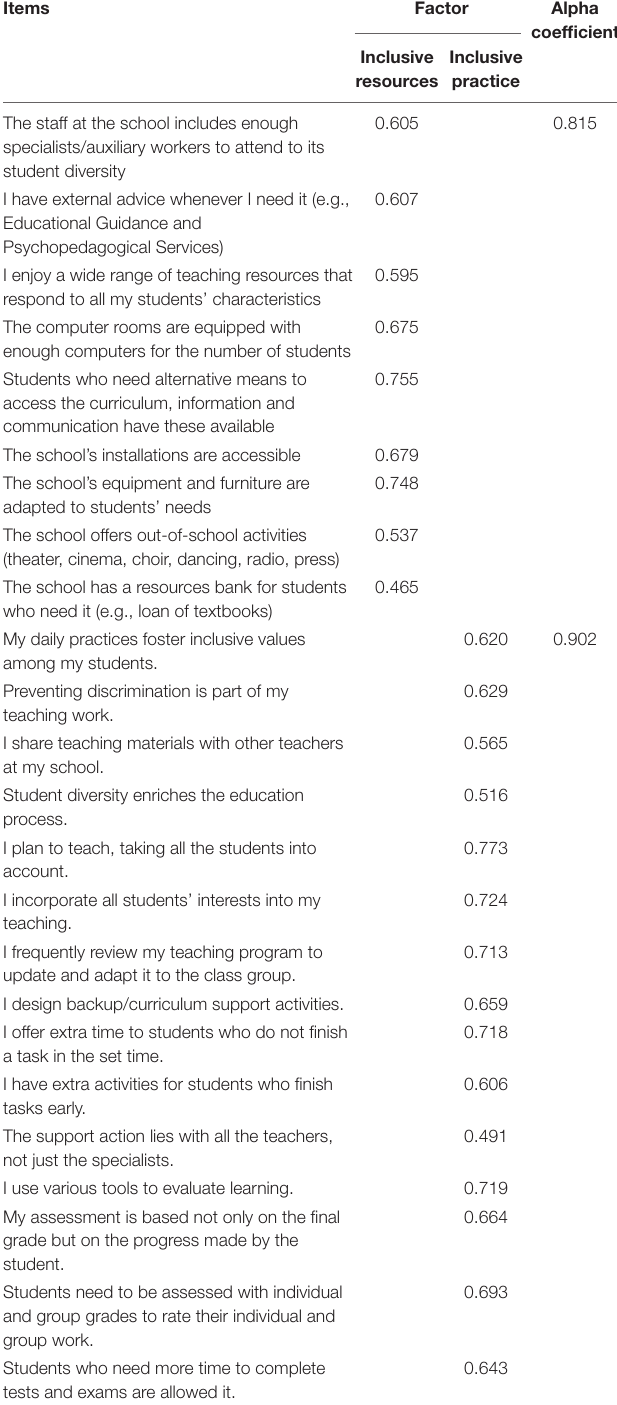
TABLE 3 | “Resources and practices for inclusive education (RPIE)”: 24 item structure